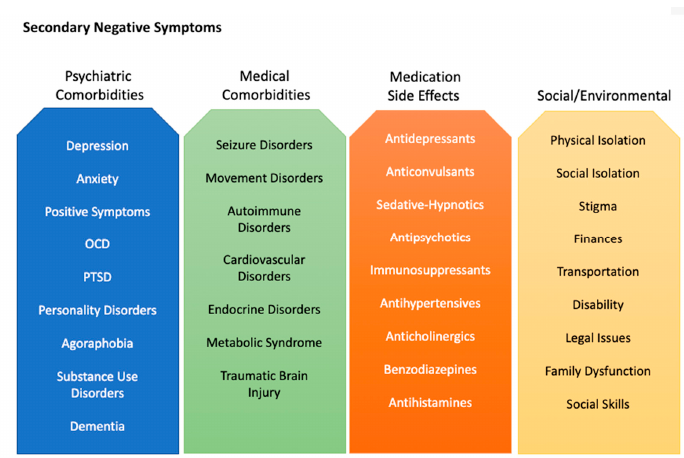
Figure 1. Actionable factors that cause or contribute to secondary negative symptoms.